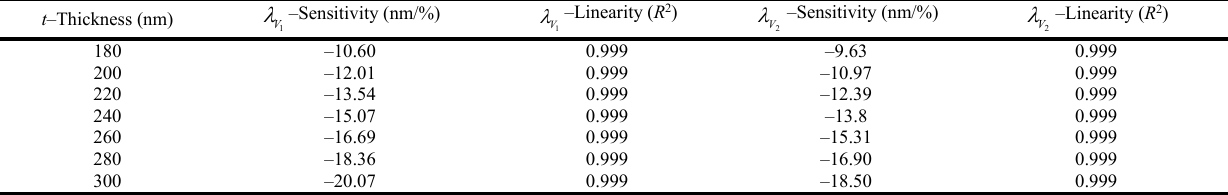
Fig. 5 Relationship between the gas sensitivity of the sensor and (a) the thickness t of the gas-sensitive film and (b) the diameters d b of air holes. Table 1 Influence of t on the sensitivity of proposed sensor.